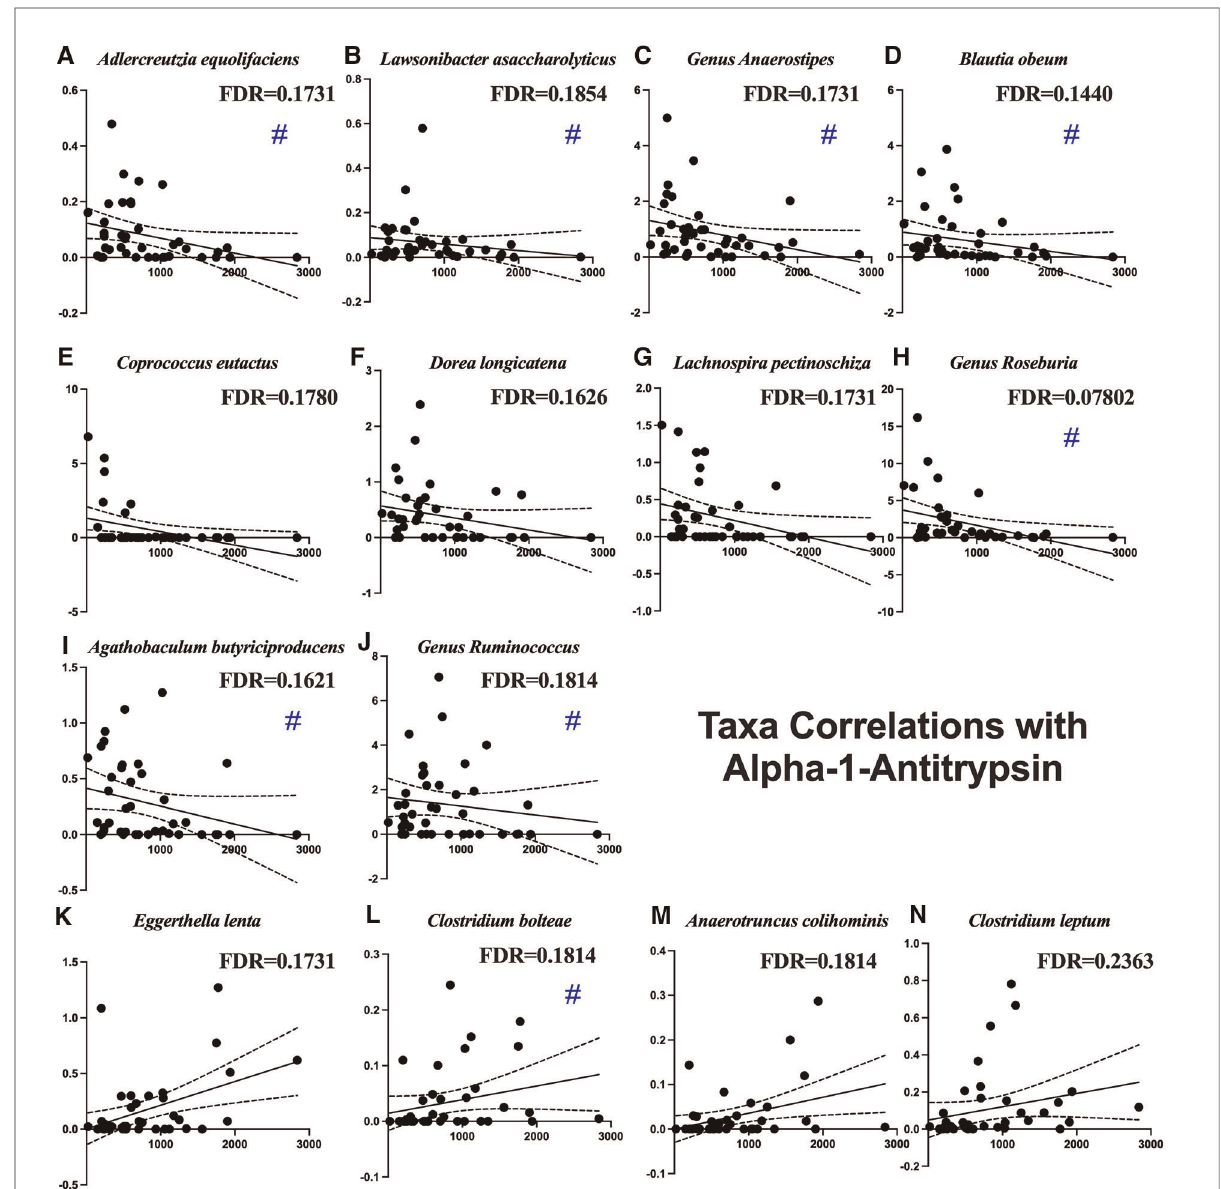
FIGURE 3 Microbial taxa associated with fecal alpha-1-antitrypsin. Blue pound signs indicate bacteria which were also associated with stroke. Negative associations include ( A ) Adlercreutzia equolifaciens , ( B ) Lawsonibacter asaccharolyticus , ( C ) the genus Anaerostipes , ( D ) Blautia obeum , ( E ) Coprococcus eutactus , ( F ) Dorea longicatena , ( G ) Lachnospira pectinoschiza , ( H ) the genus Roseburia , ( I ) Agathobaculum butyriciproducens , and ( J ) the genus Ruminococcus . Positive associations include ( K ) Eggerthella lenta , ( L ) Clostridium bolteae , ( M ) Anaerotruncus colihominis , and ( N ) Clostridium leptum